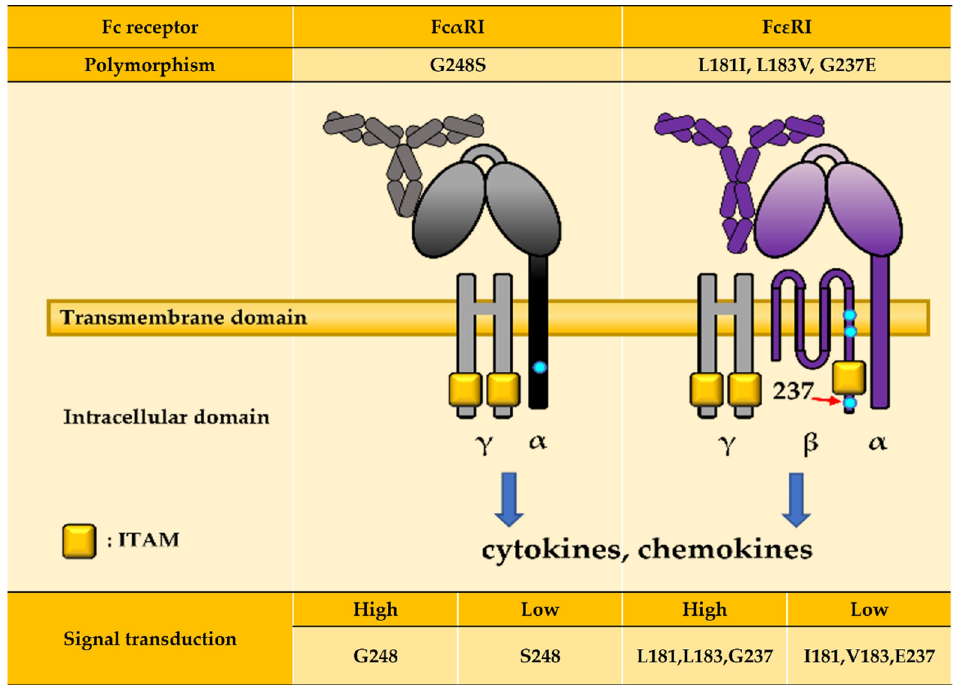
Figure 2. Polymorphisms alter signal transduction. Turquoise dots indicate amino acid sequences that affect downstream signaling pathways. G248 located in the cytoplasmic domain of Fc α RI, produces pro-inflammatory cytokines without γ -chain, compared to S248. L181 and L183, located in the transmembrane domain of Fc ε RI, are more easily seen in patients with atopy and asthma, compared to I181 and V183, respectively. G237, located in the intracellular domain of Fc ε RI, causes an excessive allergic response compared to E237.